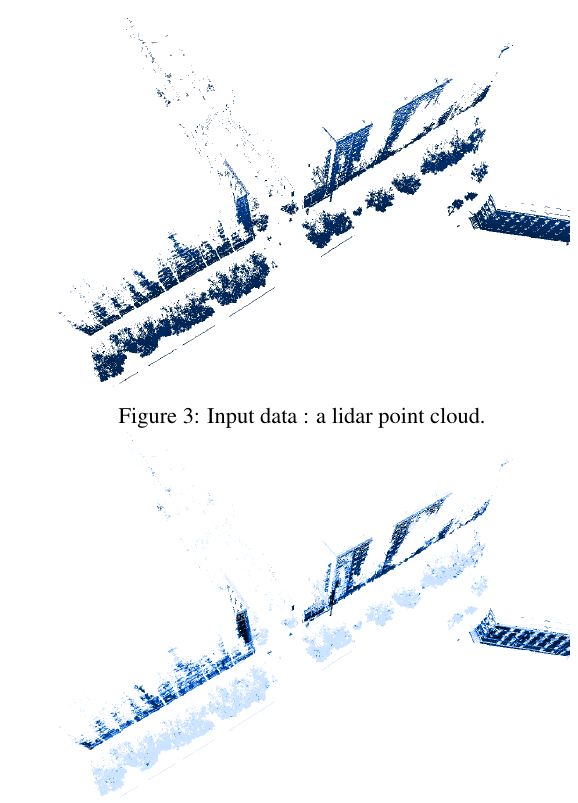
Figure 4: Probability that a point belongs to a flat vertical area.